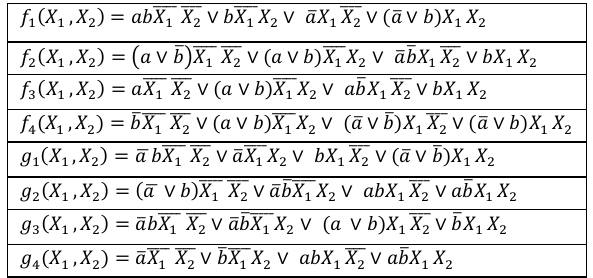
Table 2. Formulas for the pertinent functions in the eight equations used